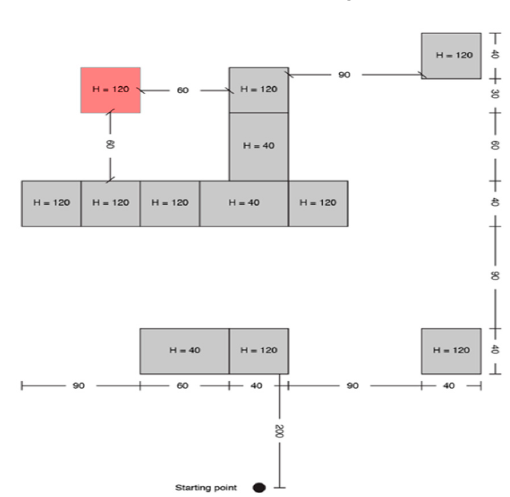
Sensors 2020 , 20 , x FOR PEER REVIEW Figure 7. Treasure hunt configuration C. Figure 7. Treasure hunt configuration C.